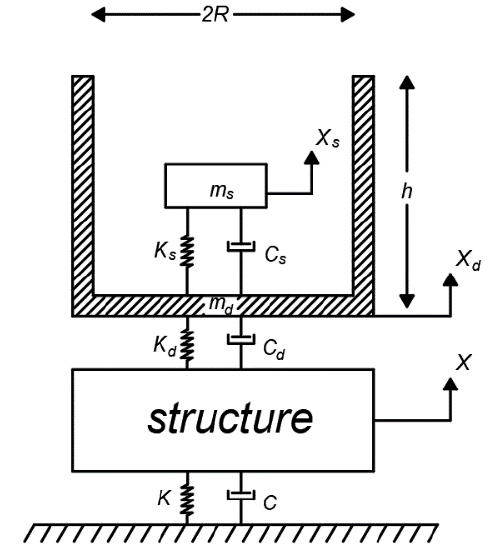
Figure 3. Cylindrical TLD + single-story structure model.